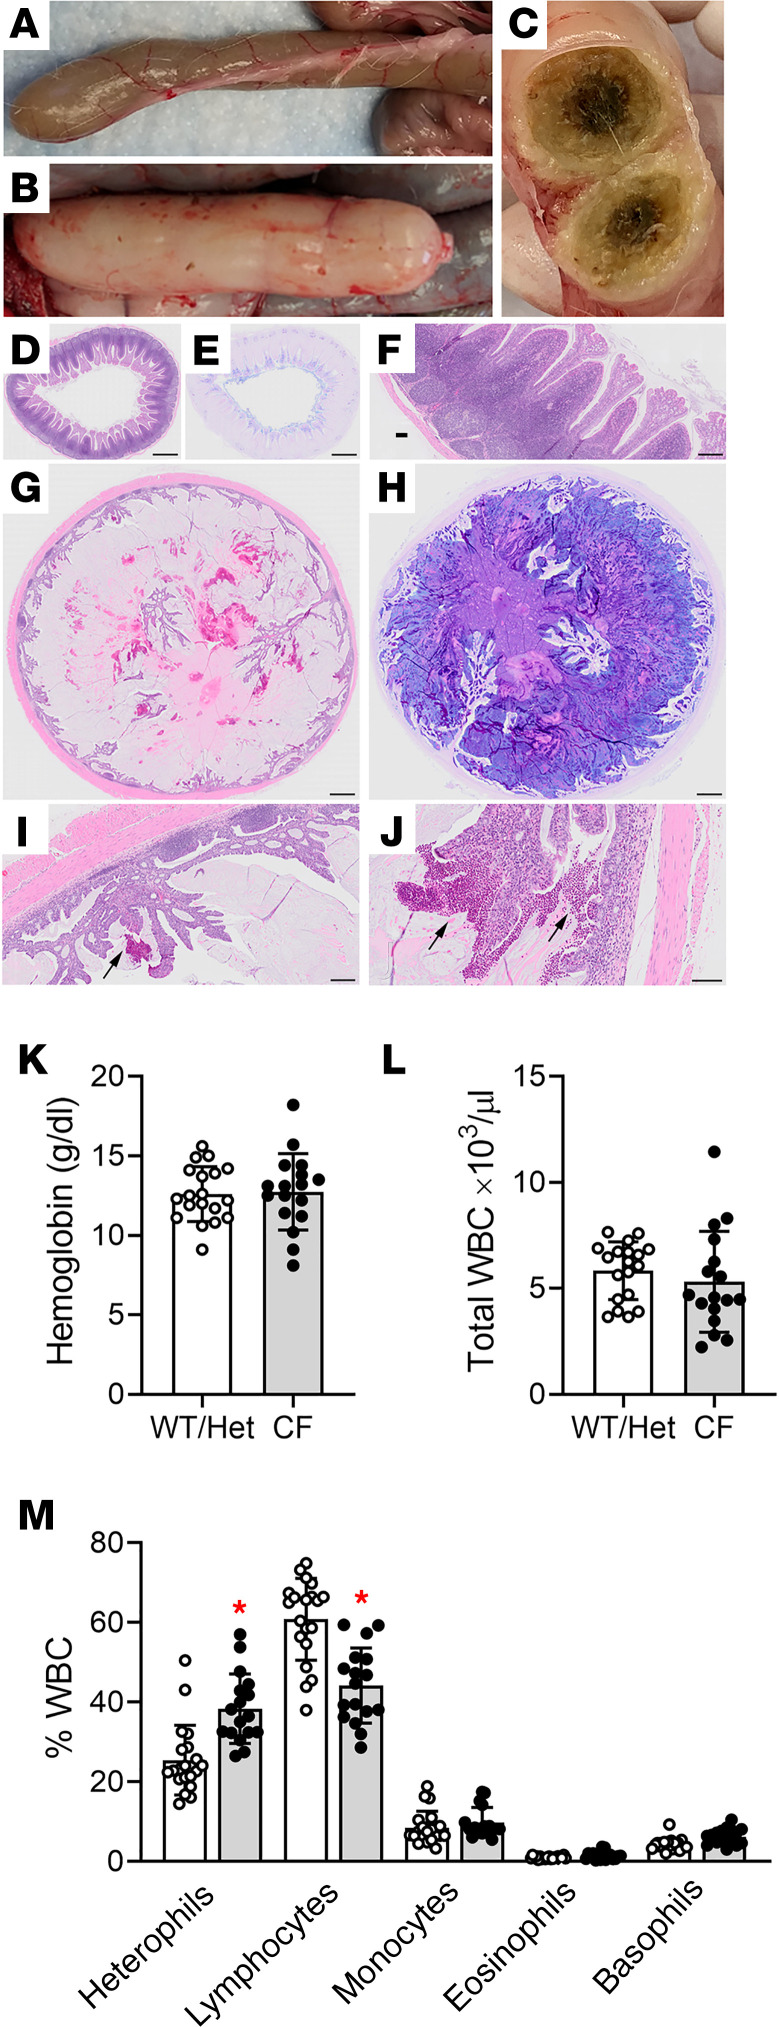
Evidence of systemic inflammation in CF rabbits.(A–C) Representative gross appearance of the vermiform appendix isolated from approximately 1-year-old WT (A) and CF (B) rabbits. CF rabbits exhibited swollen and discolored appendix as compared with WT counterparts. When cut in cross section (C), the CF appendix lumen was impacted with solid caseous material and remnants of cecal content. (D and E) Representative histology micrographs of the vermiform appendix isolated from approximately 1-year-old WT rabbit. Cross section, H&E (D) and AB-PAS (E) stain. Scale bar: 1 mm. (F) Higher magnification of the appendix mucosa in WT rabbits, H&E stain. Scale bar: 0.2 mm. (G and H) Representative histology of the vermiform appendix isolated from approximately 1-year-old CF rabbit, illustrating marked enlargement (G, H&E stain) and impaction with AB-PAS+ material (H, AB-PAS stain). Scale bar: 1 mm. (I and J) Higher magnification of the CF appendix exhibiting grossly simplified epithelial structures compared with WT, barely detectable lymphoid tissue, and intraluminal accumulation of granulocytes (arrows). H&E stain. Scale bar: 0.2 mm (I) and 0.1 mm (J). Representative micrographs from n = 5 CF and WT rabbits. (K–M) Hematologic values for WT and CF rabbits at approximately 4–5 months of age. Total hemoglobin (K), white blood cell (WBC) total (L), and differential cell counts (M). n = 19 WT (white bars, white dots) and 17 CF (gray bars, black dots) rabbits. *P < 0.05 versus WT. Unpaired, 2-tailed t test.